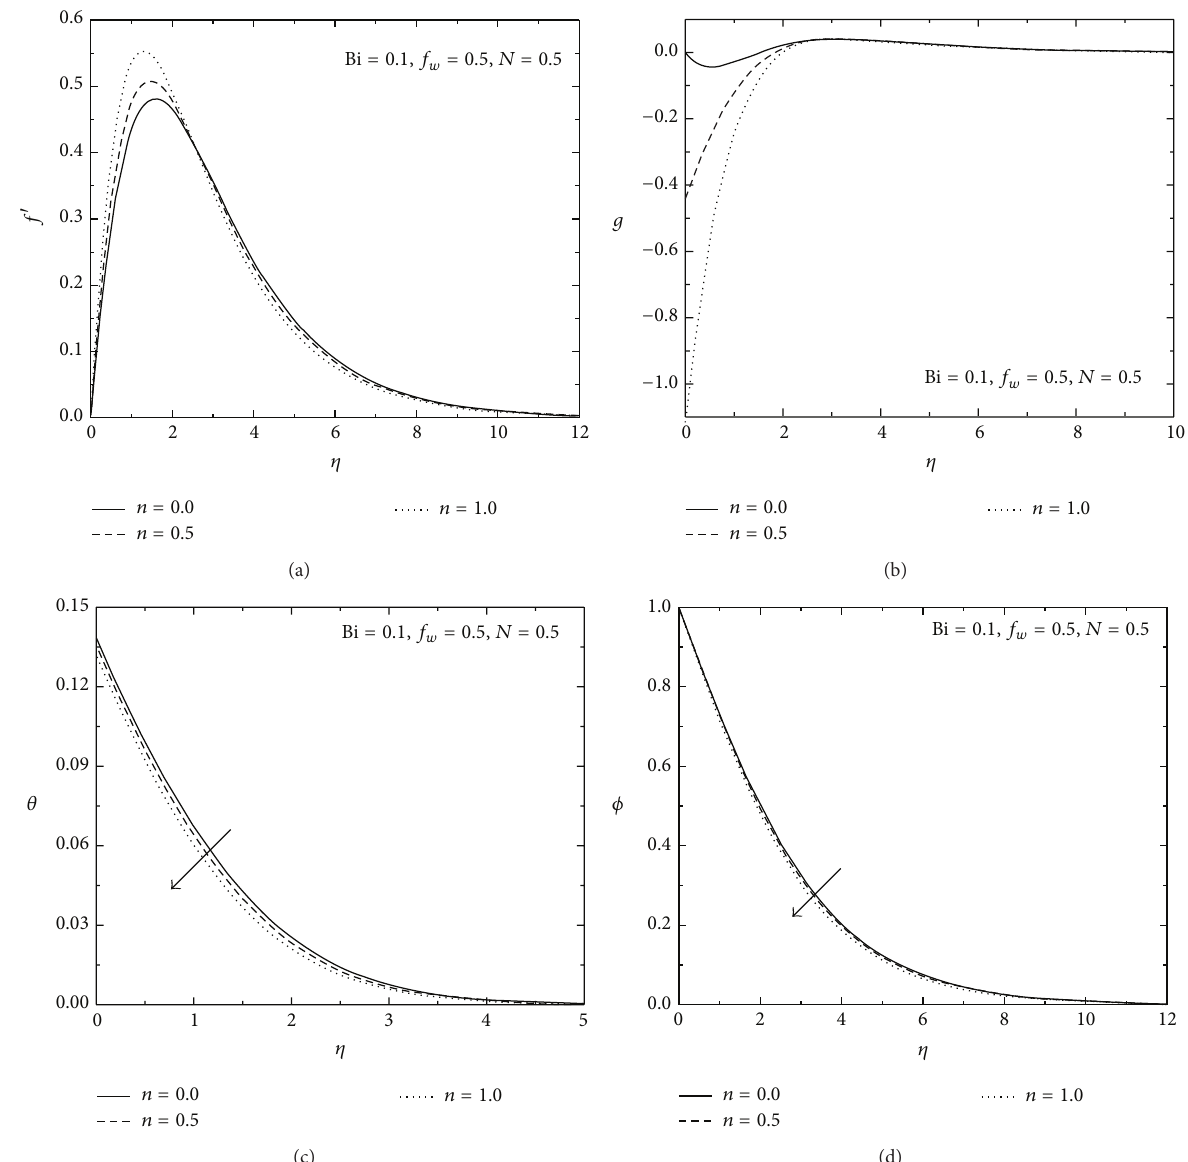
Figure 5: Effect of material parameter 𝑛 on (a) velocity, (b) microrotation, (c) temperature, and (d) concentration profiles.